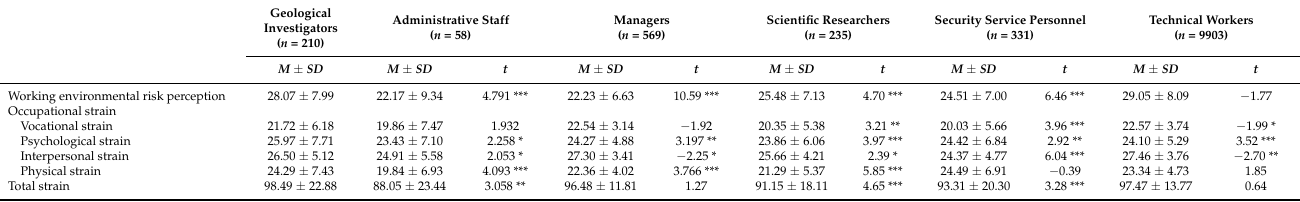
Table 2. Means, standard deviations, and T-tests of working environmental risk perception and occupational